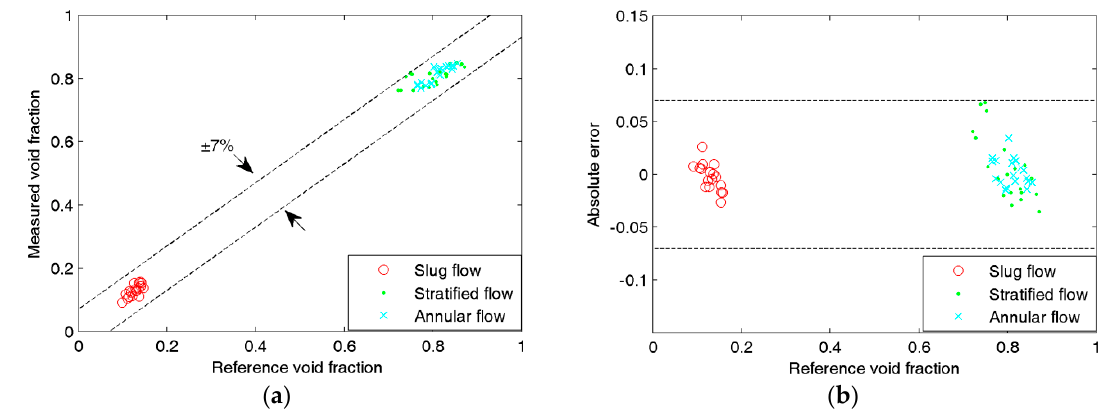
Figure 10. Experimental results of the void fraction measurement in the 2.16-mm i.d. chanel: ( a ) Comparison between measured and reference void fractions; ( b ) Absolute errors of the void fraction measurement.